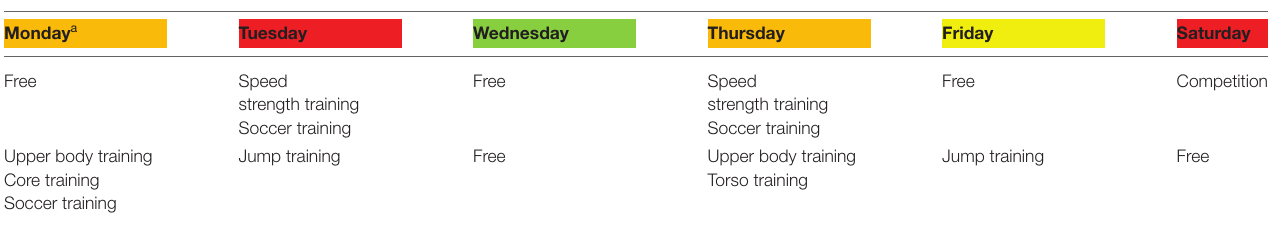
TABLE 2 | Overview of the training structure before the COVID-19